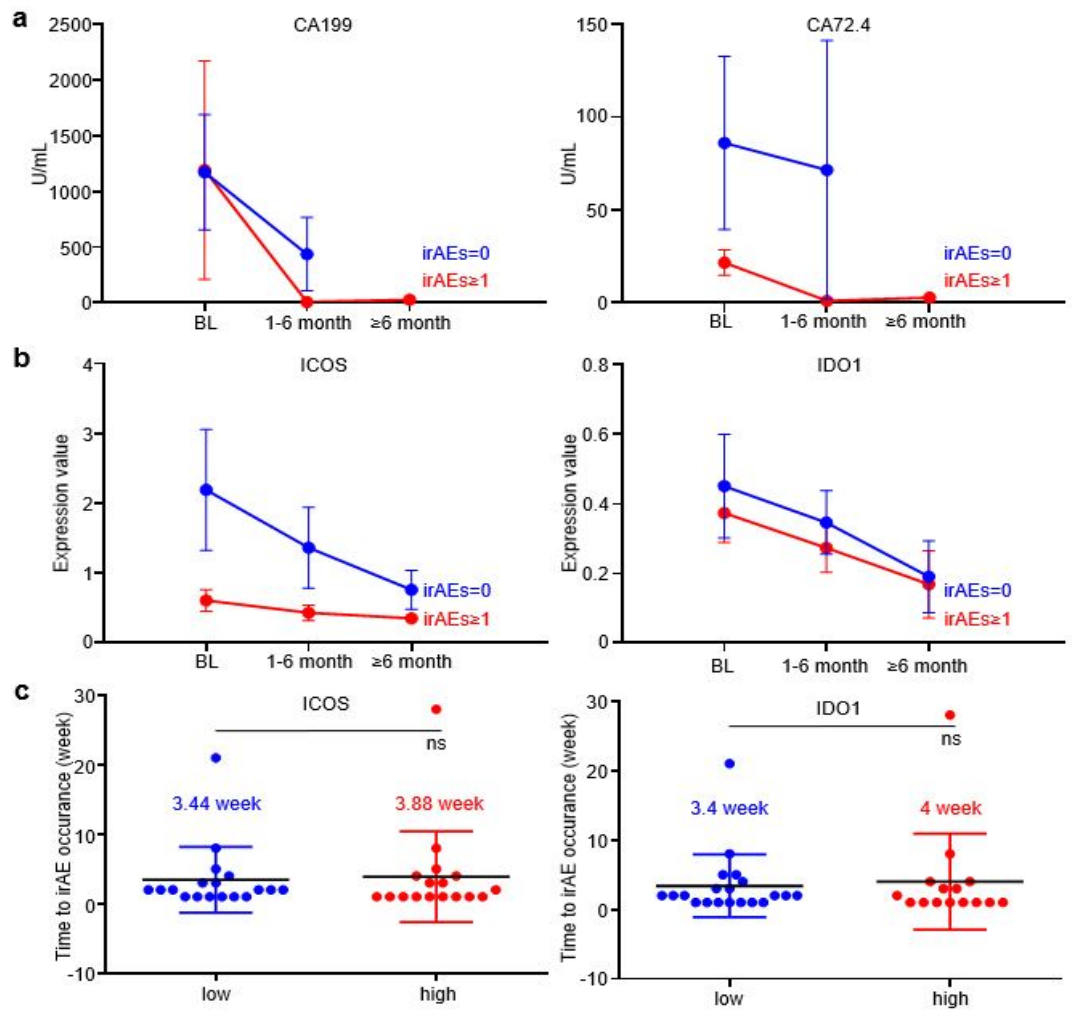
Figure 3. EV-ICOS and EV-IDO1 as dynamic predictors to forecast irAEs. ( a ) The changes of CA199 and CA72.4 in grade ≥ 1 irAEs and without irAEs patients along with the treatment. ( b ) Dynamic changes of EV-ICOS and EV-IDO1 in patients with or without irAEs group after baseline. ( c ) The relationship between baseline level of EV-ICOS and EV-IDO1 with the occurrence speed of irAEs. ns, non-significant.